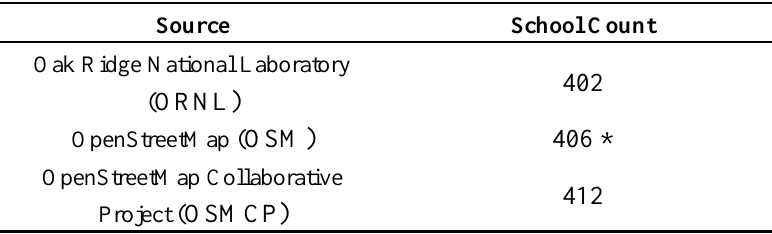
Table 1. School count by data